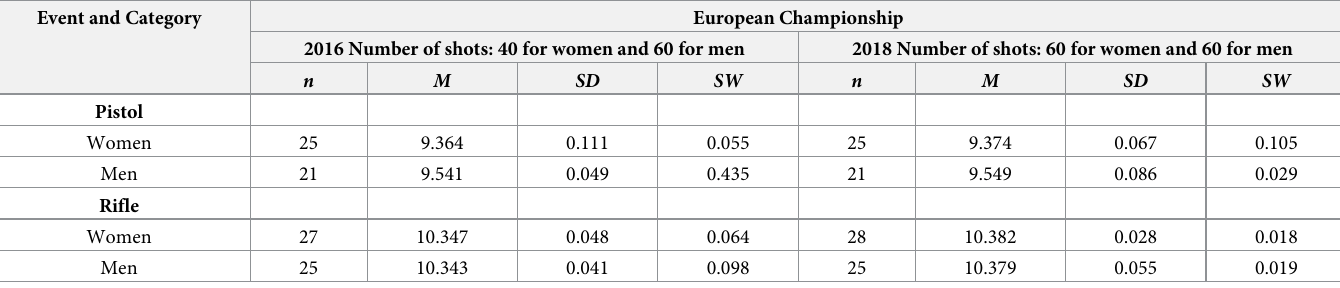
The results of the shooters who participated in a single championship, either in 2016 or 2018, are detailed in Table 2. Starting with the independent data for the air pistol event, the scores of the women who participated in 2016 ( M = 9.364) were statistically equal to the 2018 scores for women ( M = 9.374) ( p = 0.703). In addition, the men’s scores in 2016 ( M = 9.541) were signifi- cantly higher than the women’s results, both in 2016 ( M = 9.364) with a large effect size ( p < 0.001, d = 2.060, % = 1.890) and in 2018 ( M = 9.549) ( p < 0.001, d = 2.270, % = 1.870). In relation to the air rifle event, the women’s scores in 2016 ( M = 10.347) were significantly lower than the 2018 scores ( M = 10.382) with an average effect size ( p = 0.002; d = 0.790, % = 0.340). However, no significant differences were observed between men and women for air rifle per- formance either in 2016 ( M = 10.347 vs. M = 10.343, p = 0.801) or 2018 ( M = 10.382 vs. M = 10.379, p = 0.839). Table 2. Results of the shooters who participated in a single championship. Data for independent t -tests. Event and Category European Championship 2016 Number of shots: 40 for women and 60 for men 2018 Number of shots: 60 for women and 60 for men n M Pistol Women